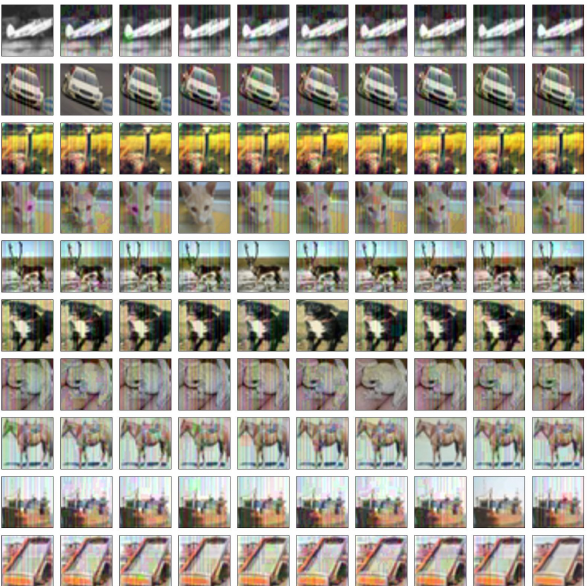
Figure 6. Adversarial examples generated by QuEry Attack on CIFAR10, with (cid:101) = 12/255. An image at row , col = i , i shows the original image for class i . An image at row , col = i , j , i (cid:54) = j shows a targetted attack on class i , with the target being class j